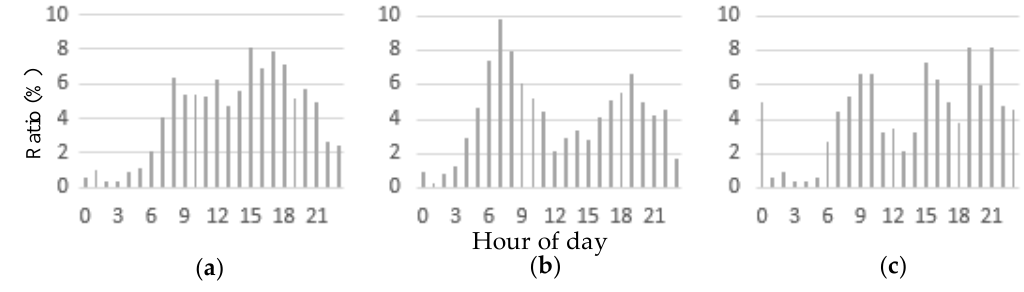
Figure 3. Hourly ratios of crimes: ( a ) theft of e-bike; ( b ) burglary; and ( c ) robbery.